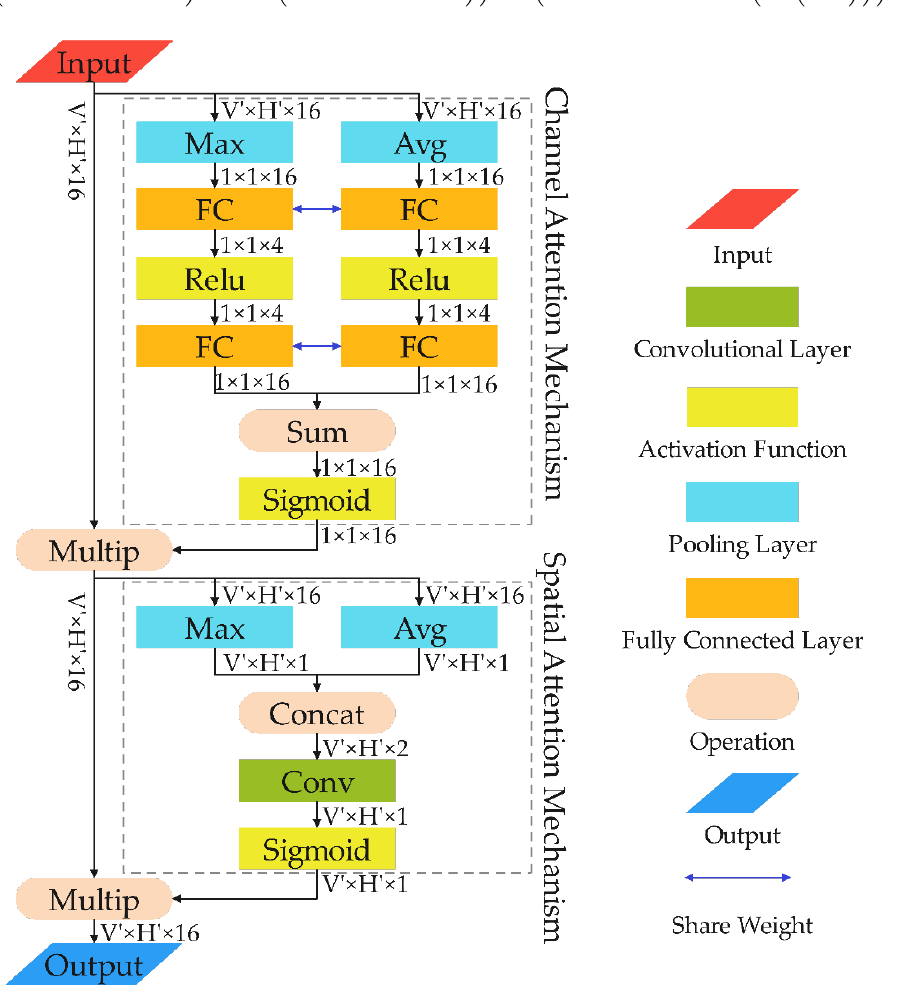
Figure 4. Attention mechanism.